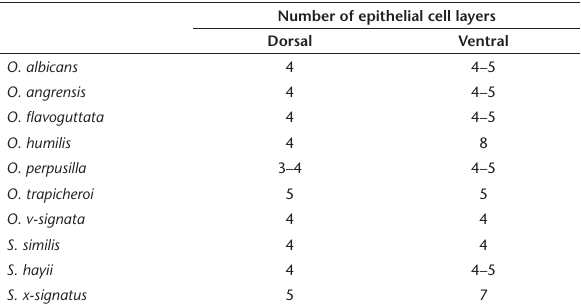
Table 2. Number of epithelial cell alyers of Oloygon spp. and Scinax